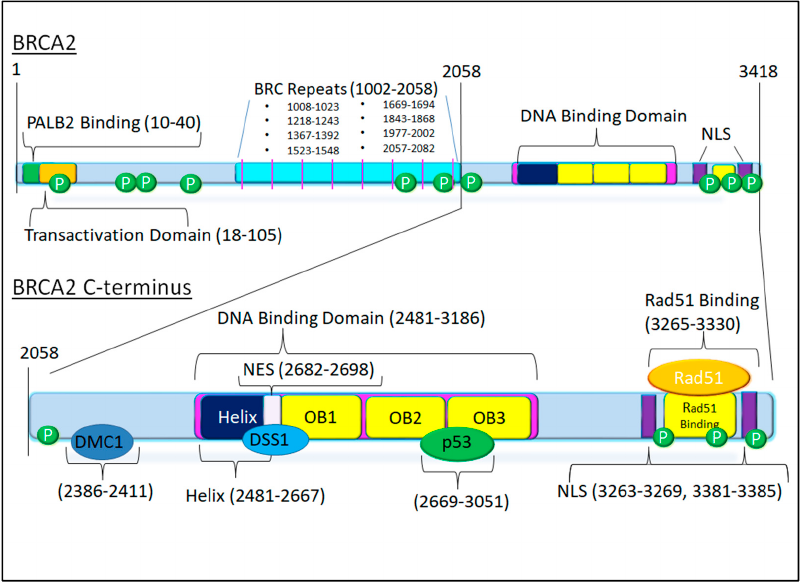
Figure 1. The BRCA2 Protein. The C-terminus of the protein (shown expanded in the bottom of the figure) from amino acid 2058, immediately after the BRC repeats, to the end of the protein, amino acid 3418. The C-terminus contains several features of note, including a DMC1 binding site, a DNA-binding domain in which there is a nuclear export sequence masked by DSS1 binding as well as a p53 binding site, and a Rad51 binding site. Two nuclear localization signals flank the Rad51 binding site. Phosphorylation sites are present at S2095, S3291, S3319, and